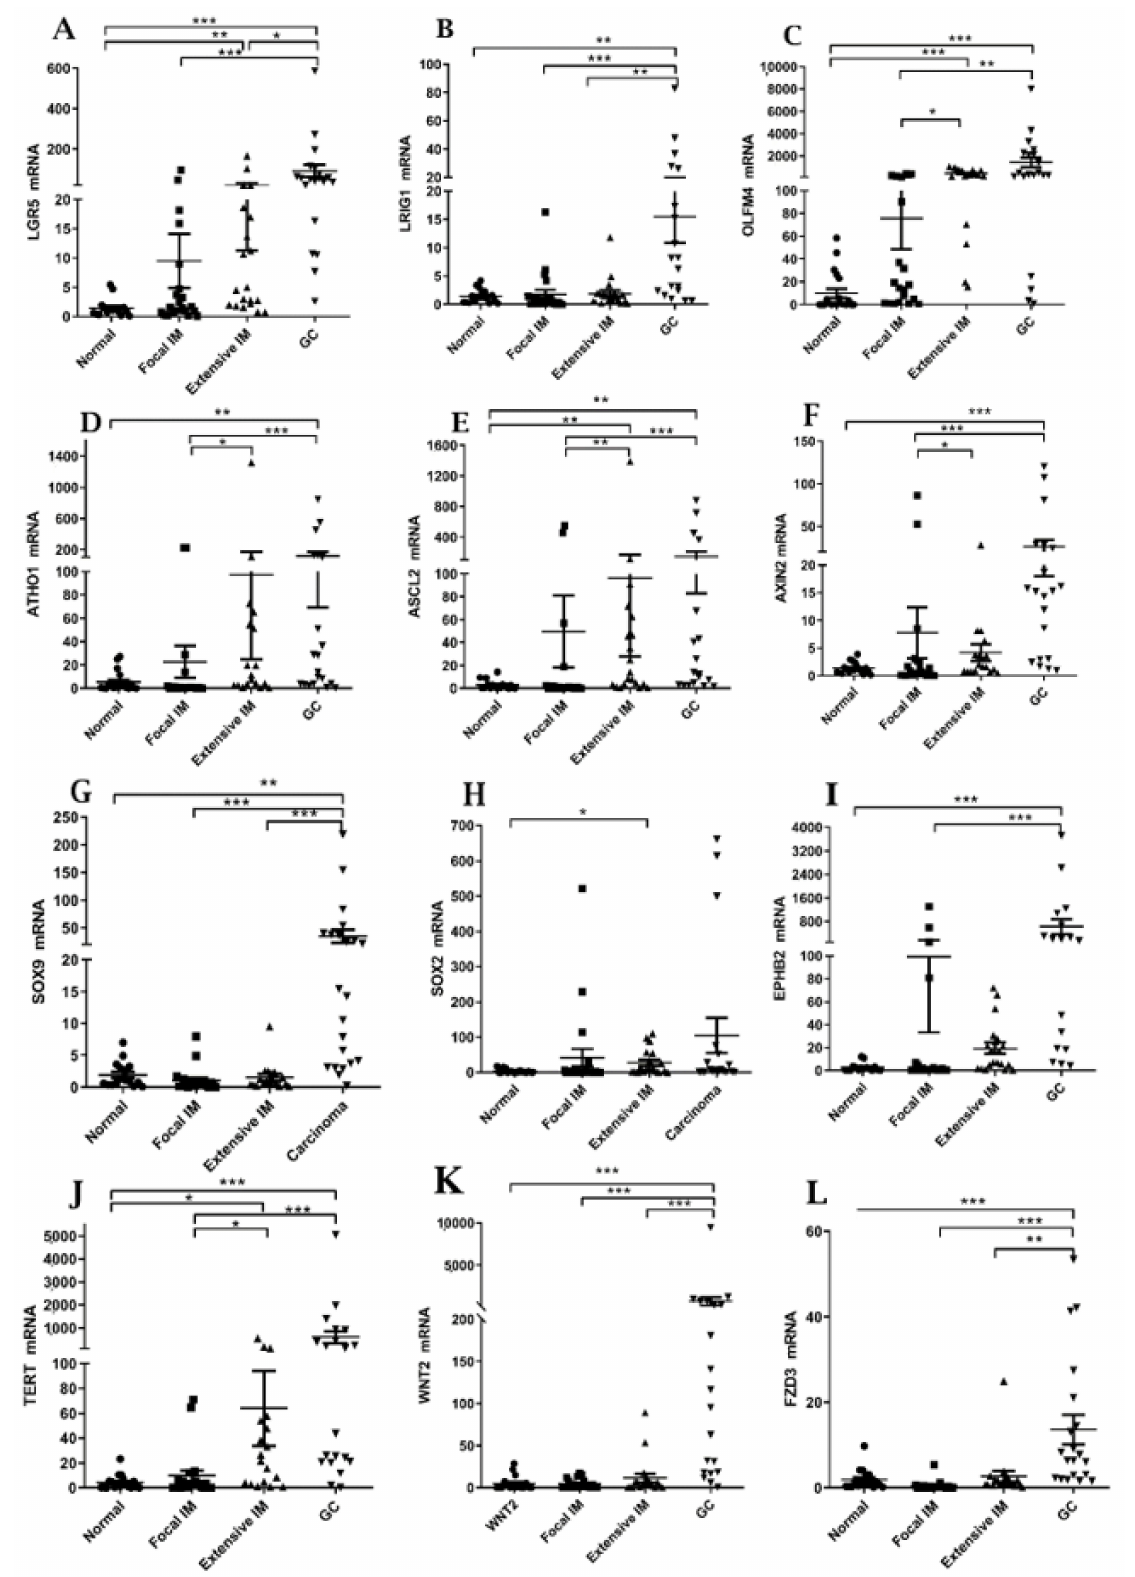
Figure 7. Expression levels of ISC marker genes in the four tissue categories. ( A - L ) Summary of qPCR quantification of gene transcripts. * p < 0.05; ** p < 0.005; *** p < 0.001. Mean ±